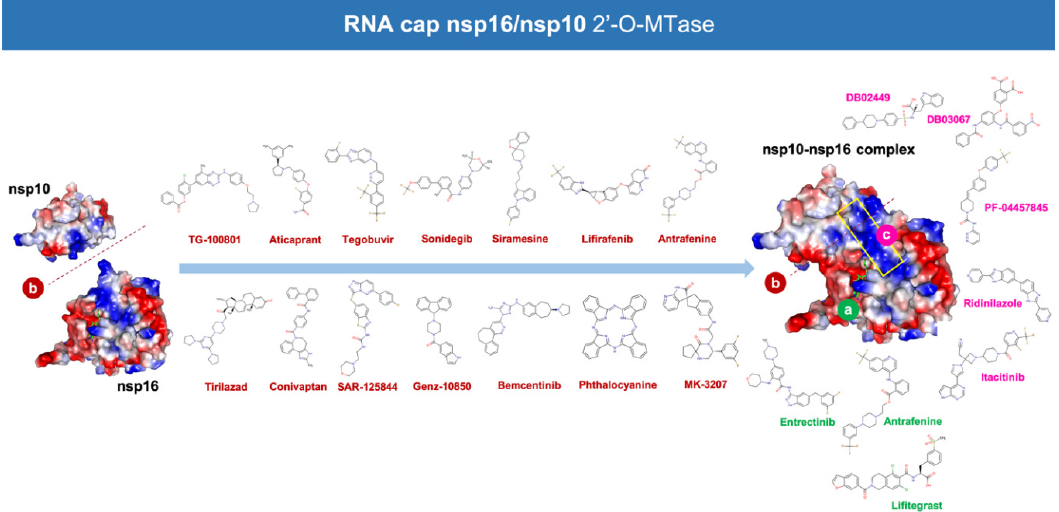
Figure 2. Predicted potential inhibitors of the nsp16/nsp10 2 ′ -O-MTAse complex. Structures of the potential drugs were predicted to target: ( a ) the (nsp10-stabilized) S-adenosyl- l -methionine (SAM)-binding pocket of nsp16 (green code), ( b ) the unique “activating surface” between nsp16 and nsp10 (brown code), and ( c ) the (nsp10-extended) RNA-binding groove of nsp16 (pink code).